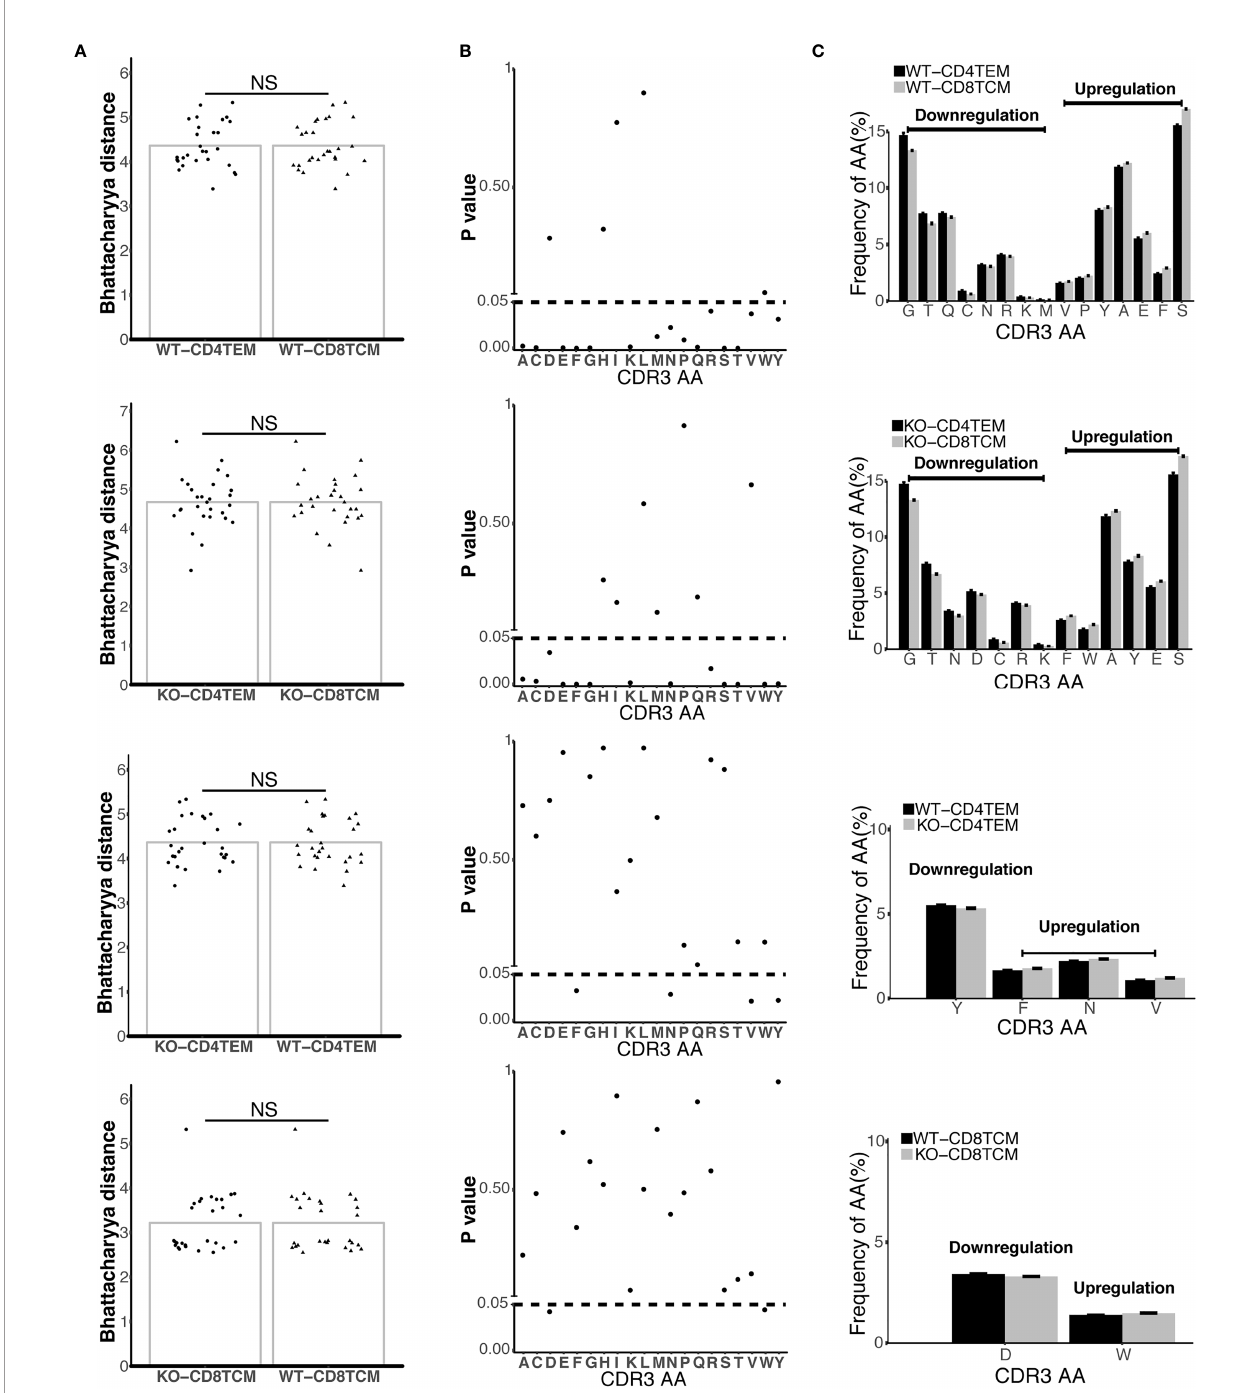
FIGURE 5 | Differential composition of CDR3 amino acids (aa) in TCRV b repertoires from four compare groups. Bhattacharyya distance analysis for the similarity of CDR3aa from four compare groups: CD4 + TEM vs. CD8 + TCM in WT chimeras, CD4 + TEM vs. CD8 + TCM in KO chimeras, WT vs. KO chimeras in CD4 + TEM, and WT vs. KO chimeras in CD8 + TCM (from up to down) (A) . The frequencies of 20 aa in CDR3 from four compare groups (B) . Downregulation and upregulation of CDR3 AA in the different groups were shown (C) . p < 0.05. NS, No Signi fi